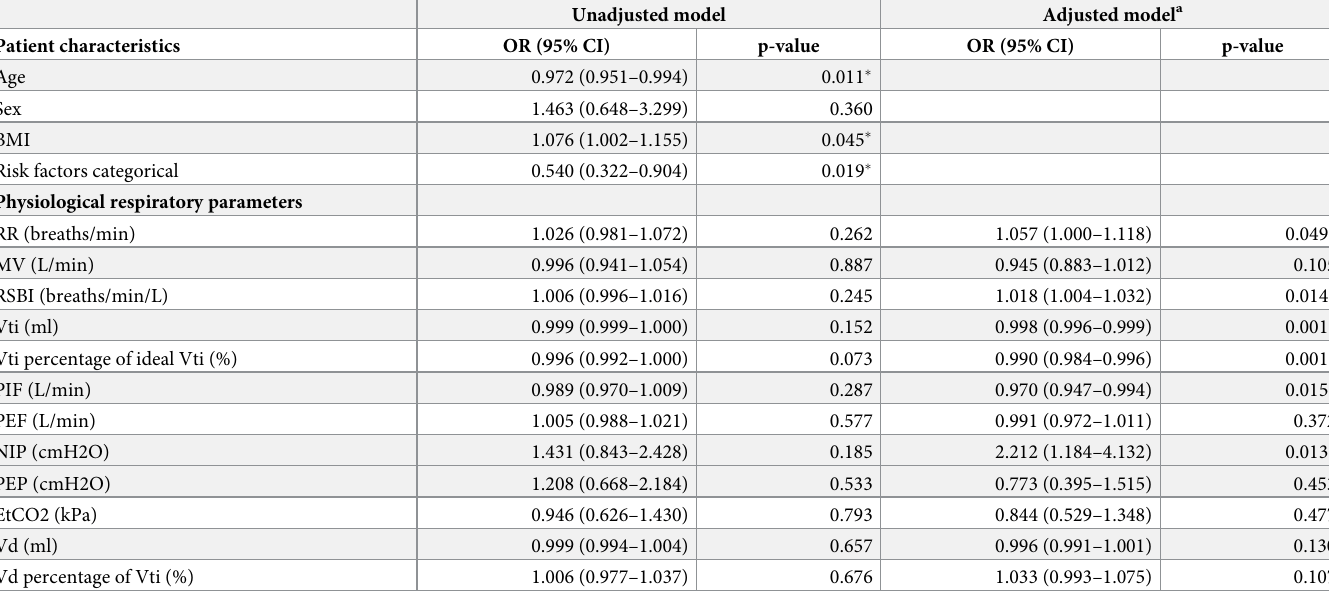
Table 4. Logistic regression models of physiological respiratory parameters effect the odds of having COVID-19.